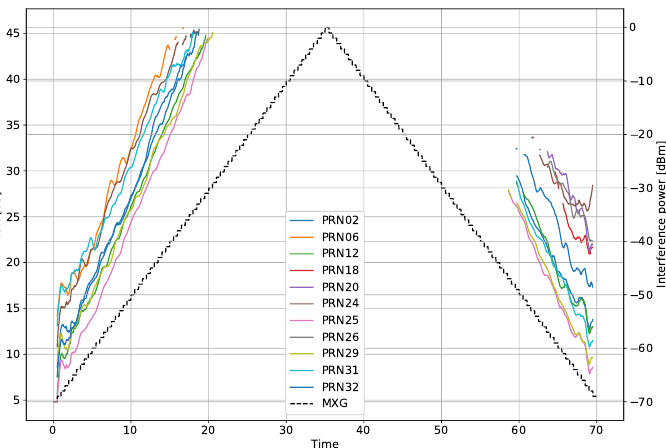
Figure 4. Estimated ISR from the 4MHz bandwidth filtered noise interference scenario.